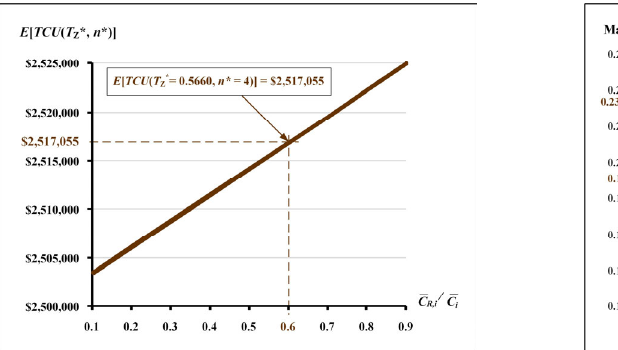
various system expense